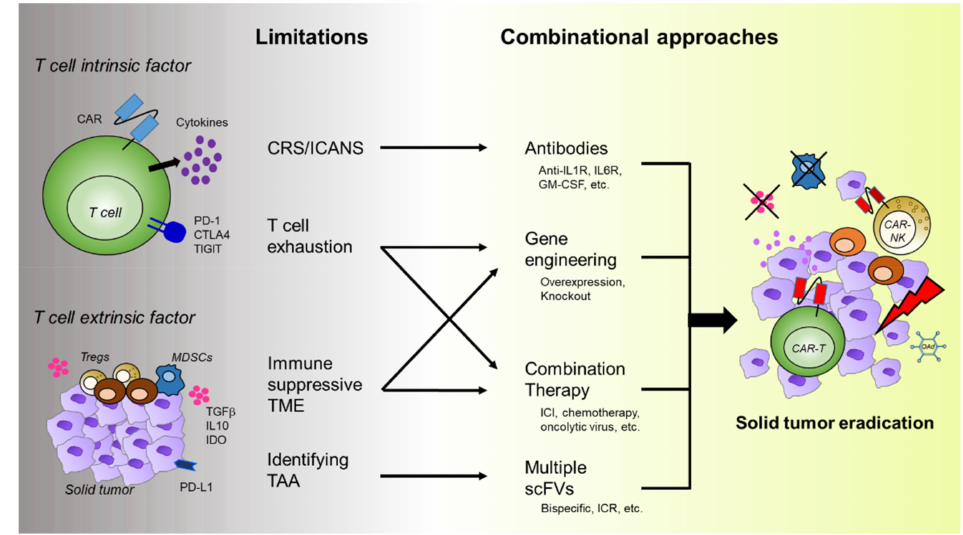
Figure 2. Therapeutic strategies to overcome current limitations and improve CAR-T cell efficacy in solid tumors. The current problems of CAR-T cell therapies in solid tumors can be categorized into T cell intrinsic factor and T cell extrinsic factor, which is described in Section 3. The conventional CAR-T cells can be further modified genetically to express more CARs, impair inhibitory immune checkpoints (such as PD-1 and CTLA-4), or retain activation genes, such as chemokine receptors and interleukins. In addition, a variety of drugs including immune checkpoint inhibitors are currently being tested in combination with CAR-T cell preclinically and clinically. Alternatively, cancer vaccine or CAR-NK cells are also being developed for the next generation cancer immunotherapy. CAR —chimeric